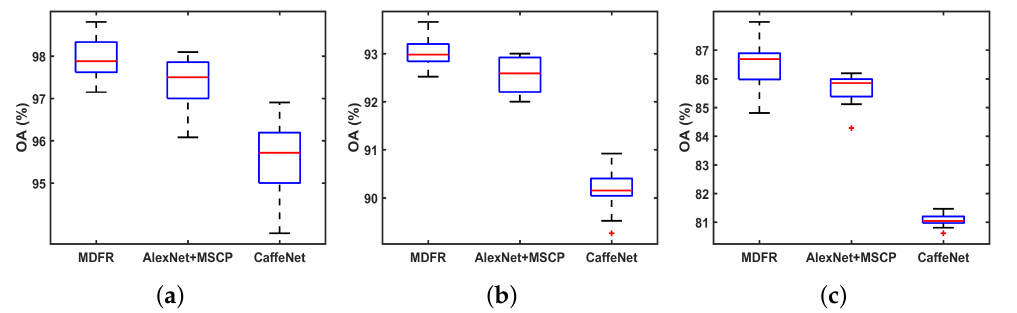
Figure 11. Box plots of different methods. From top to the bottom are the plots by ( a ) UCM, ( b ) AID, ( c )